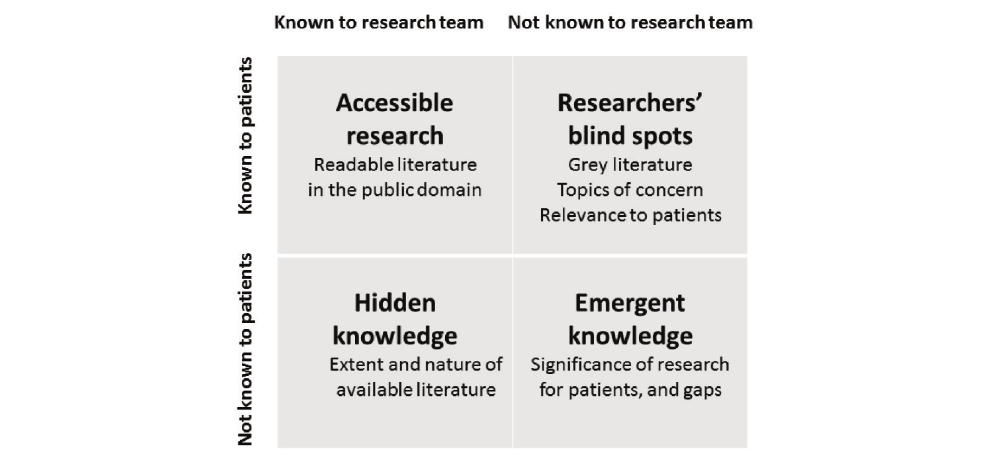
Figure 5: What patients and researchers know about Lyme